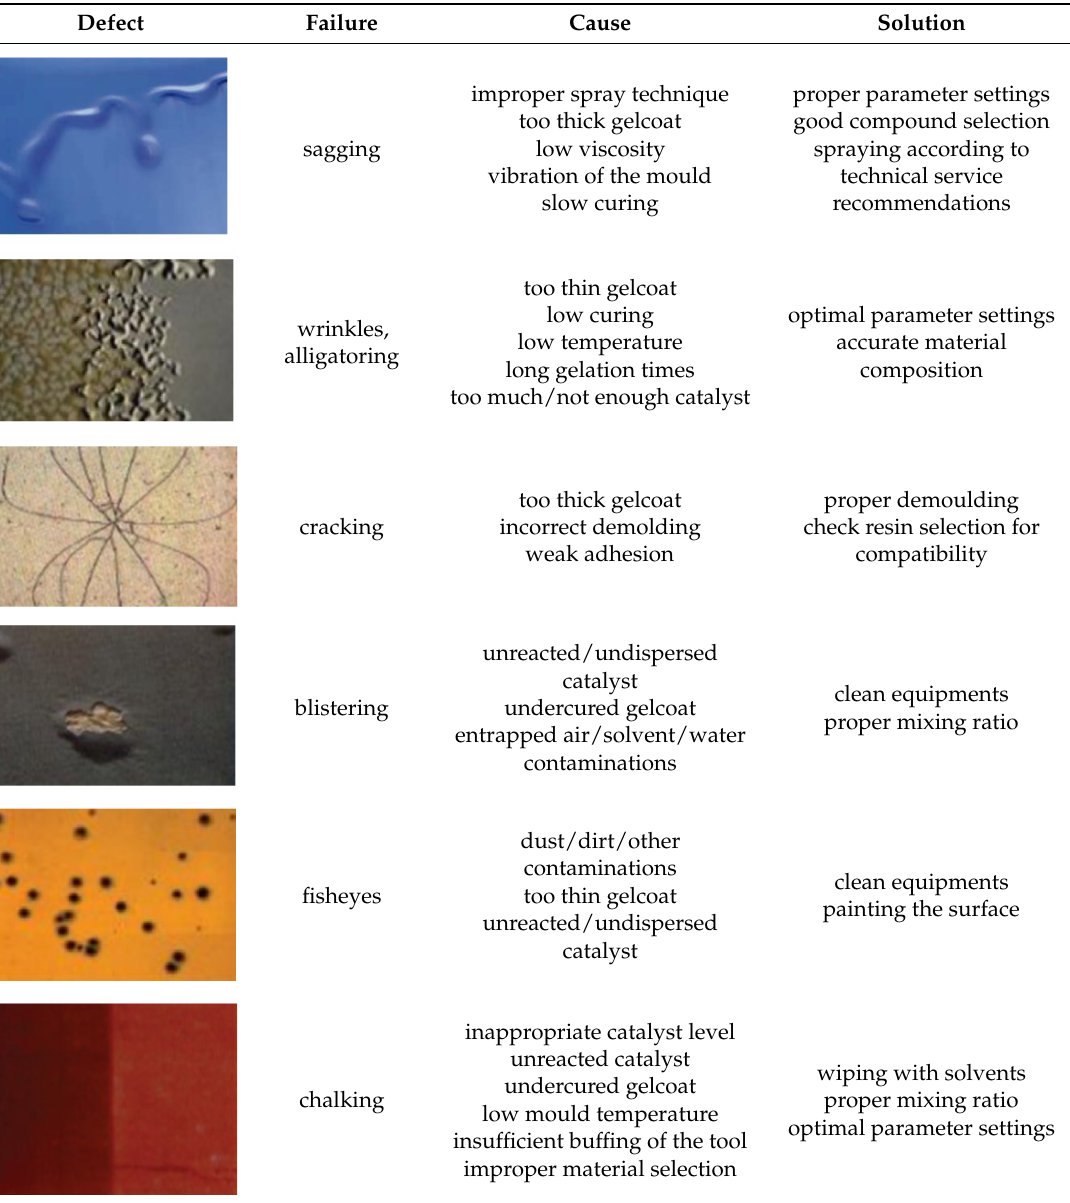
Table 3. Common gelcoat defects